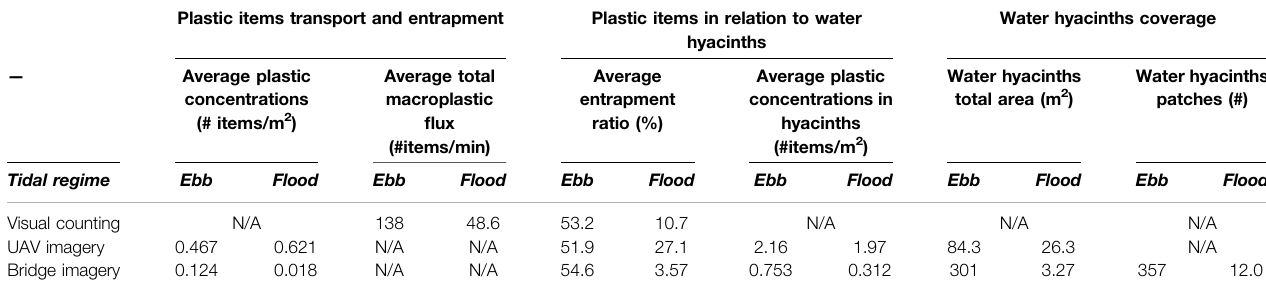
TABLE2| Plasticconcentrations,entrapmentratiosandmacroplastic fl uxinebband fl owtide fl owsonMay23,2020.Themacroplastic fl uxaverageswereintegratedforthe entire river